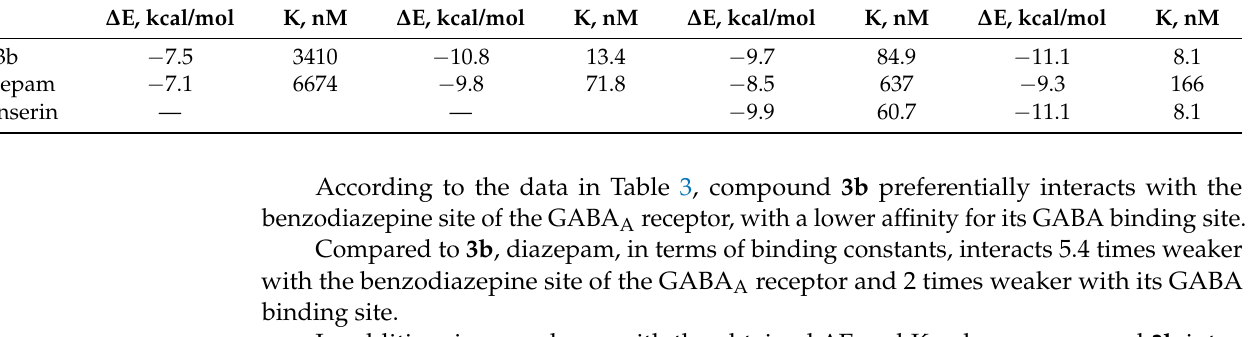
Table 3. Docking energies and binding constants of compound 3b and reference drugs for the sites of GABA A and 5-HT 2A human receptors. GABA A Receptor 5-HT 2A Receptor GABA Site Benzodiazepine Site Specific Site Allosteric Compound